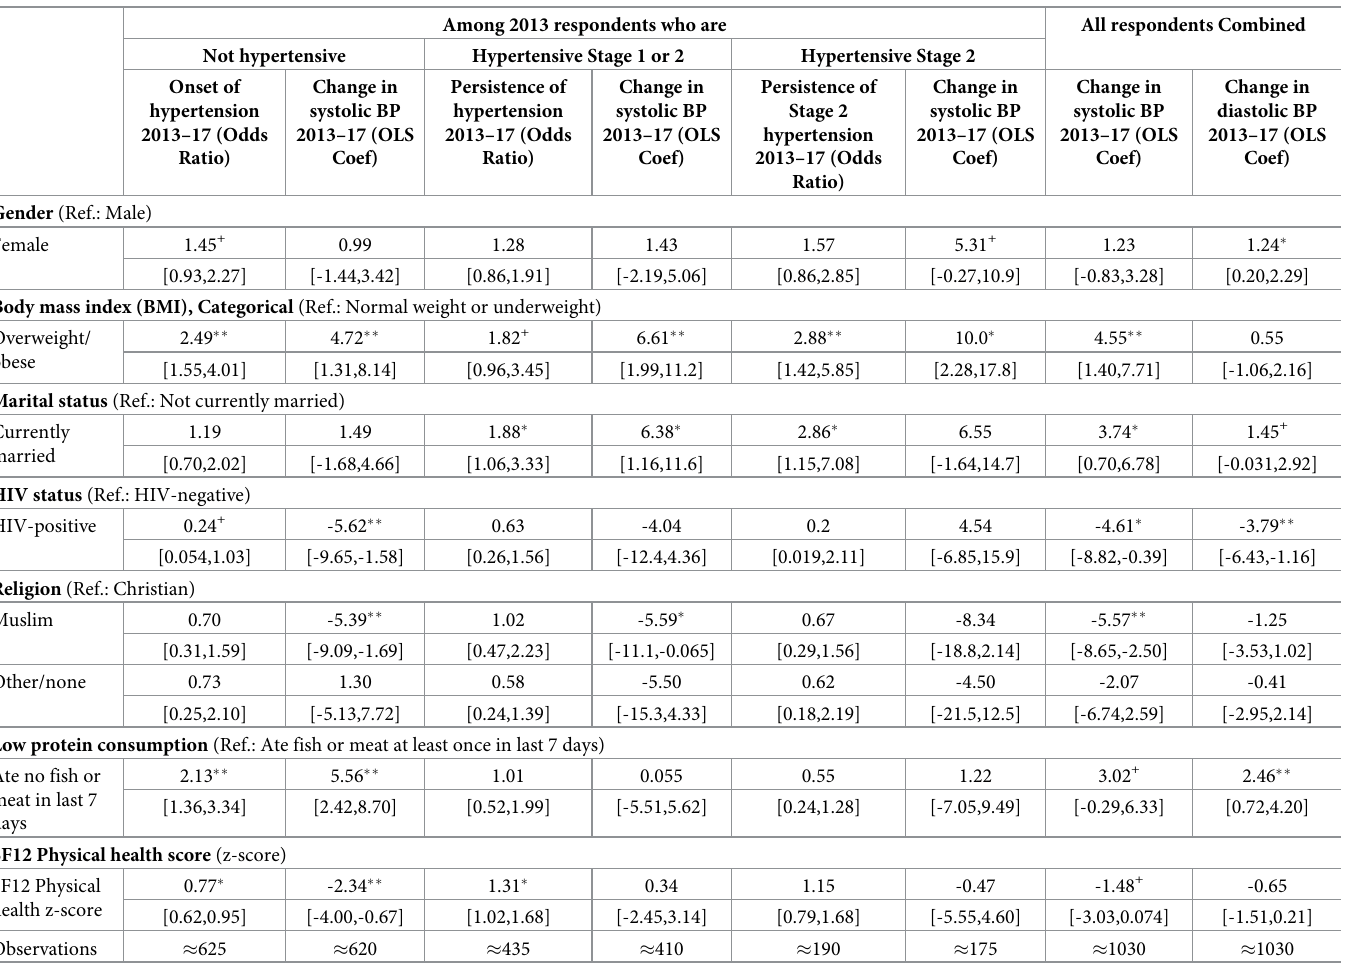
Table 2. Predictors of changes in systolic blood pressure, onset and persistence of hypertension. Among 2013 respondents who